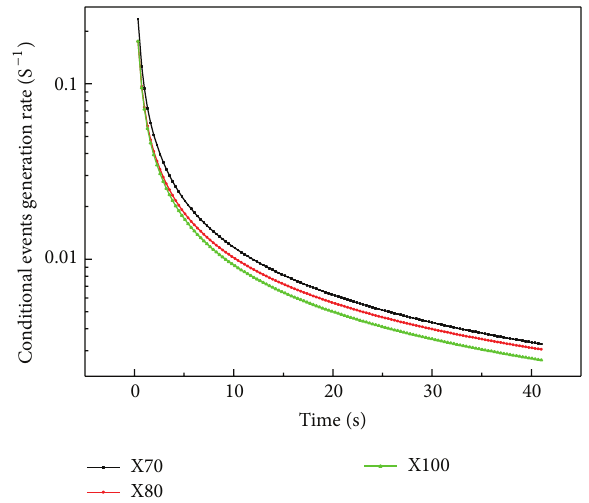
Figure 11: The plots of pit initiation rate of passive films for X70, X80, and X100 pipeline steel.